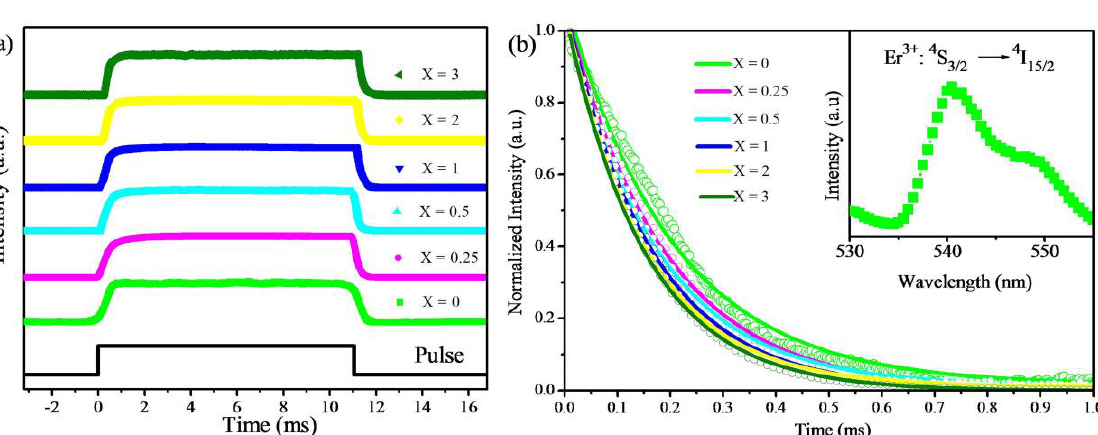
Figure 7. ( a ) Luminescence rise and decay curves of the Er 3+ : 4 S 3/2 → 4 I 15/2 transition in NaYF 4 : Yb/Er/Nd (20/2/ X mol%) nanoparticles under a pulse 808-nm excitation (pulse width = 11.05 ms); ( b ) luminescence decay curves of the Er 3+ : 4 S 3/2 → 4 I 15/2 transition in NaYF 4 : Yb/Er/Nd (20/2/ X mol%) nanoparticles. The inserted image is